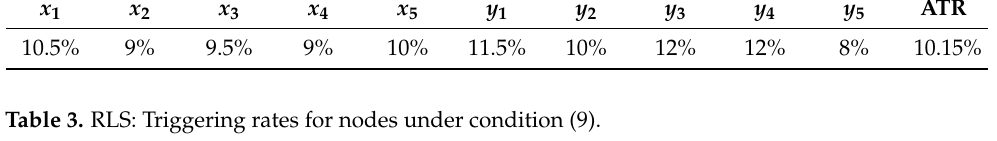
Table 2. Intra-layer quasi-synchronization (ALQS): Triggering rates for nodes under condition (7). x 1 x 2 x 3 x 4